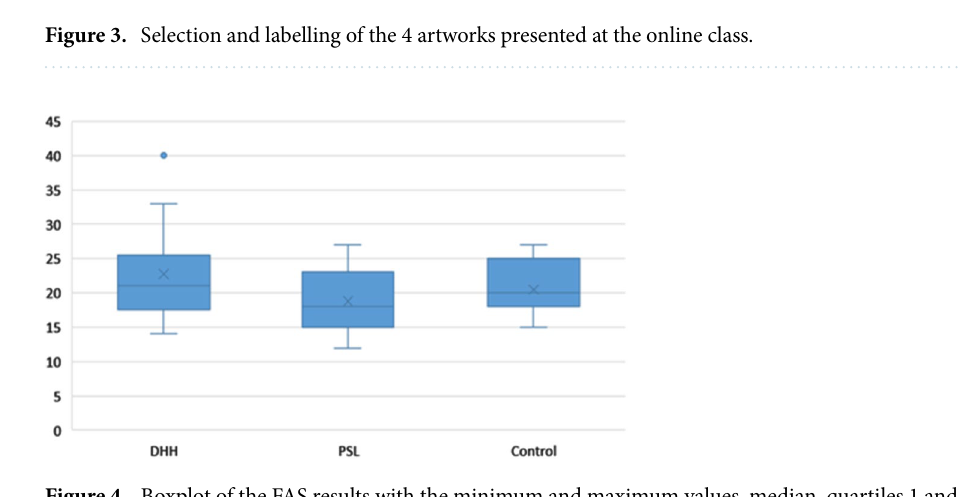
Figure 4. Boxplot of the FAS results with the minimum and maximum values, median, quartiles 1 and 3 and outlier value for the